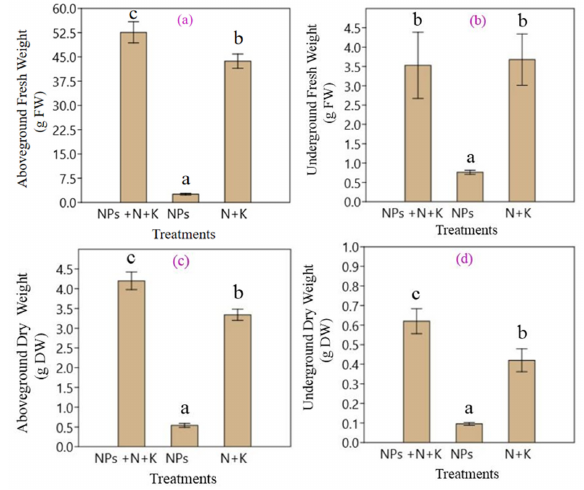
Figure 4. The ration effects of biochar nanoparticles, nitrogen, and potassium on Chinese cabbage of fresh ( a , b ) and dry ( c , d ) weight of plants after four weeks treatments. (Note, NPs+N+K: BNPs-N- K=1:2:2 (T1), NPs: BNPs-N-K=2:0:0 (T5), N+K: BNPs-N-K=0:2:2 (T6); BNPs, biochar nanoparticles; 1 unit means 0.5 g/L nutrient; Error bars indicate standard error of the mean; Different letters indicate